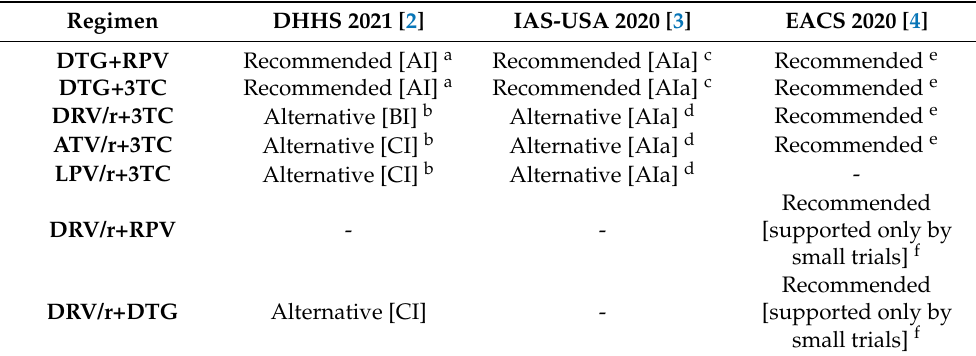
Table 4. Latest international recommendations for the switch to oral two-drug regimens in patients who achieved virological control with three-drug cART.